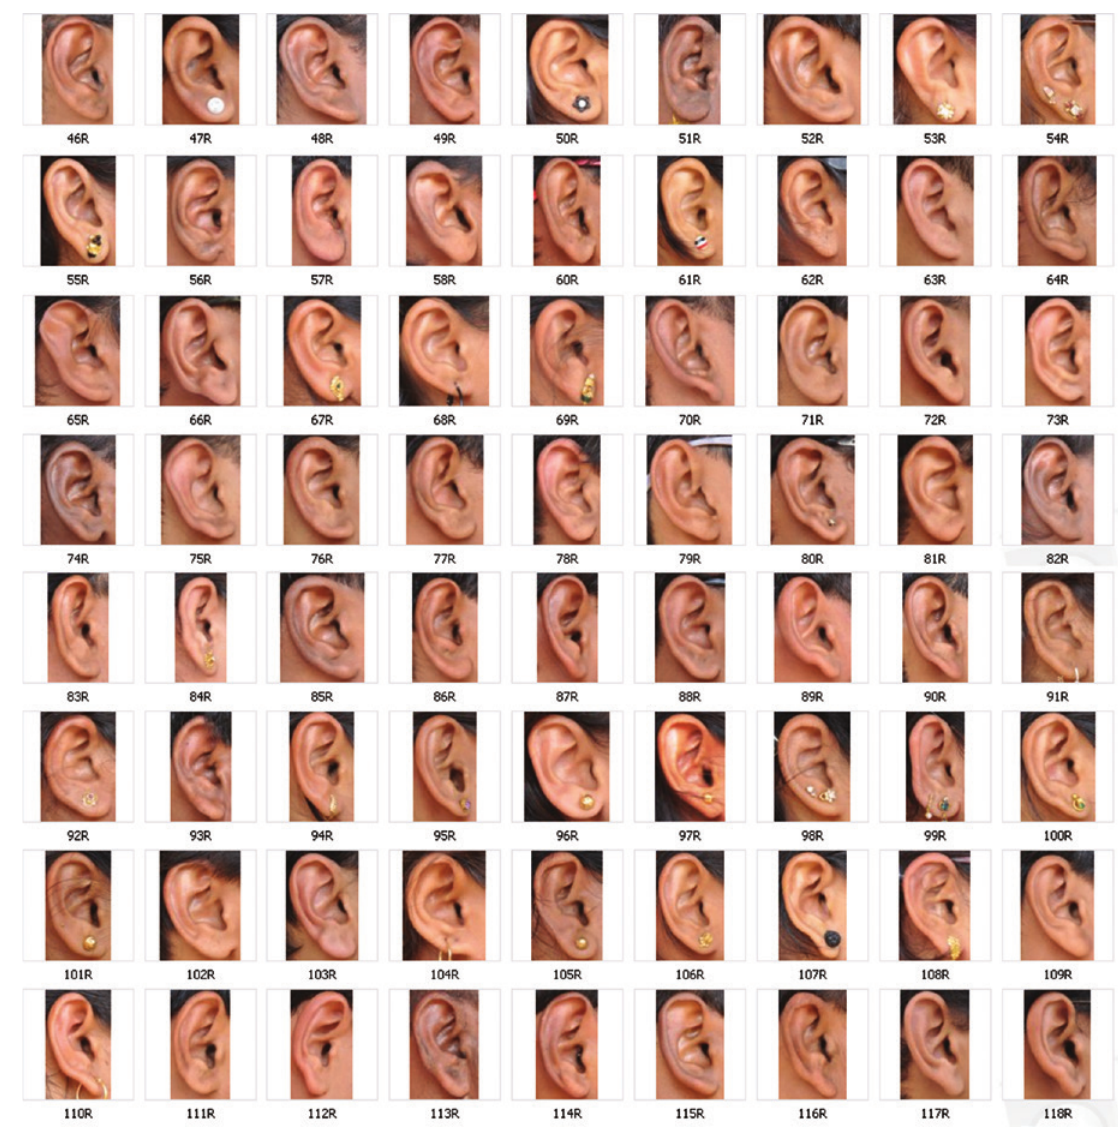
Figure 2: A Gallery Sample